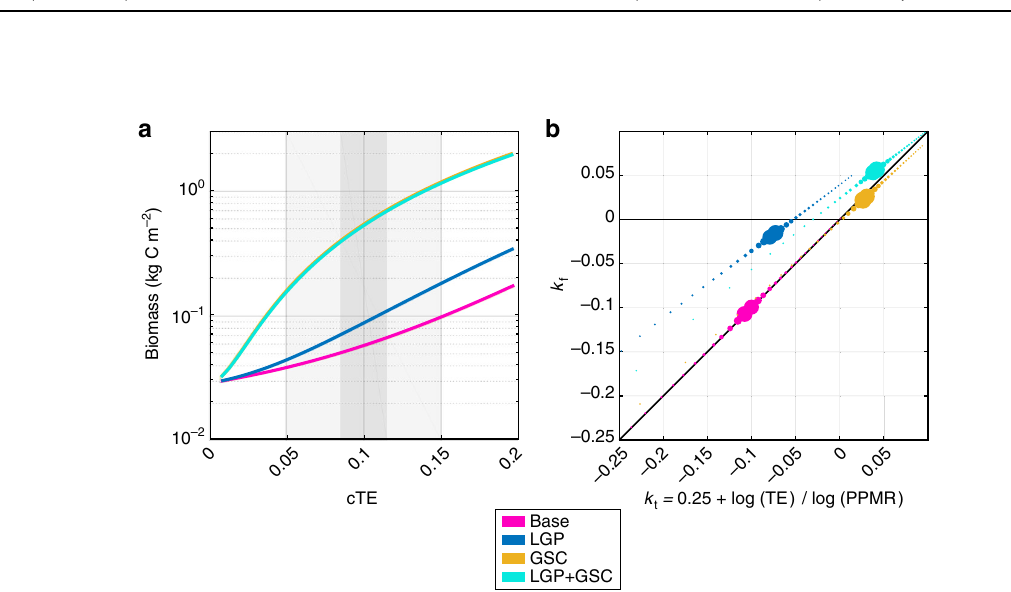
Percent increase in parentheses represents the increase relative to the base for biomass and relative to theoretical prediction for k . Constant trophic ef fi ciency (cTE = 0.101 ± 0.058)